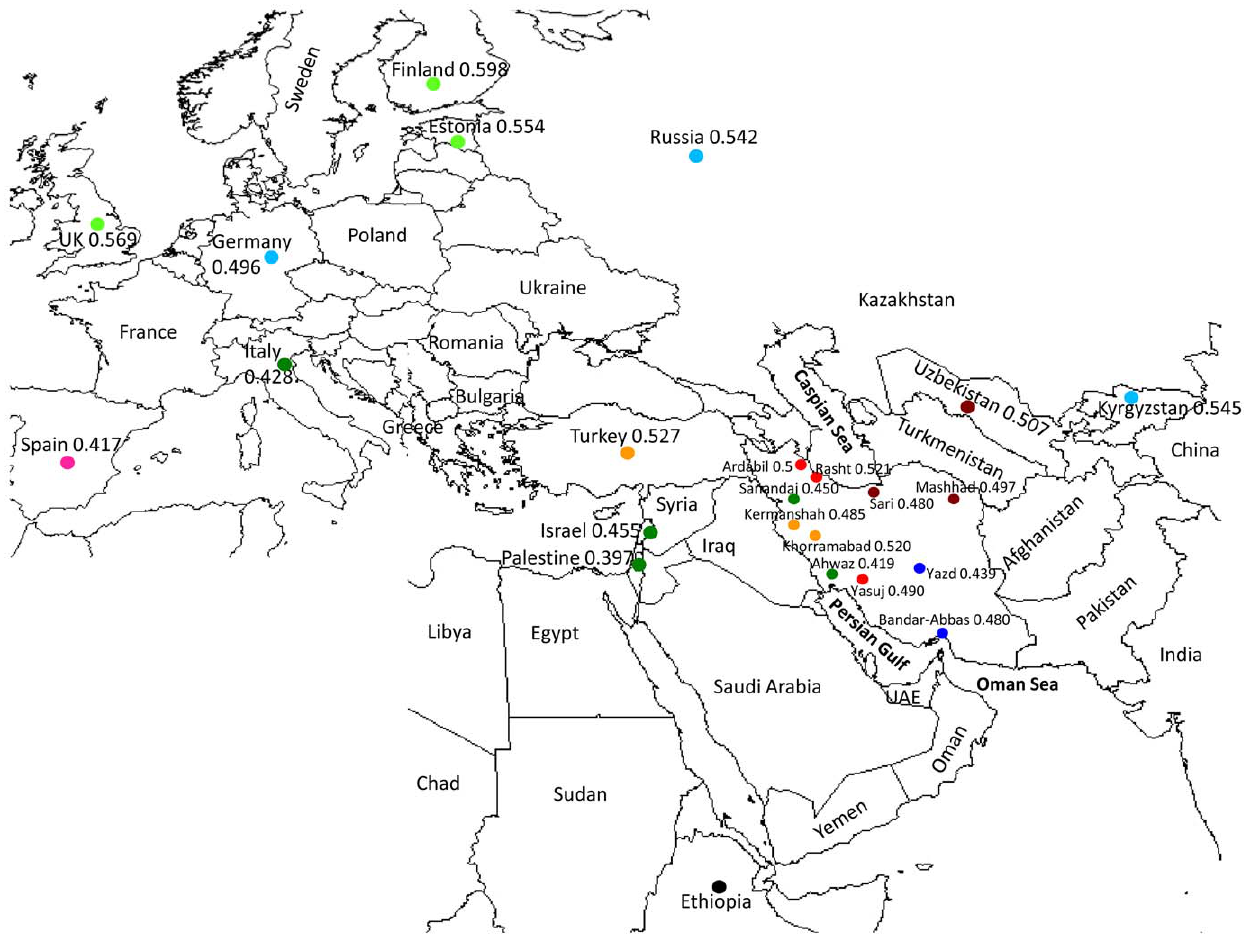
Figure 1. A detailed map with the labelled geographical locations that H.pylori populations were isolated. The proportion of AE1 nucleotides is indicated for each population. The proportion of AE2 ancestry is 1.0-the proportion of AE1 ancestry. The sample sizes for the non- Iranian samples were UK 7, Finland 10, Estonia 8, Russia 159, Kyrgystan 9, Turkey 19, Spain 71, Italy 7, Palestine 11, Israel 58, Germany 22, Uzbekistan (Uzbek) 55, Uzbekistan (Tajik) 17.